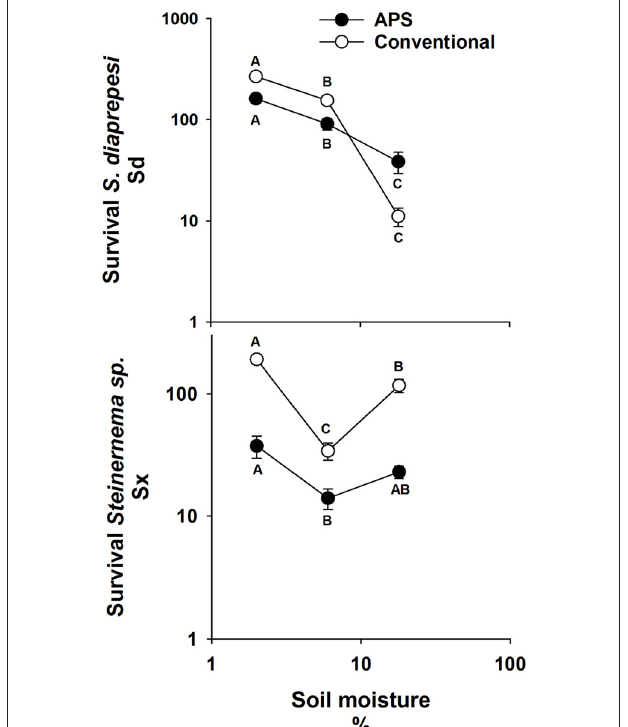
FIGURE 2 | Mean (and standard error) number of infective juvenile Steinernema sp. and S. diaprepesi recovered following 7 d of storage in field capacity (6%) or saturated (18%) sand that originated from experimental field plots managed with conventional or advanced citriculture methods. Data shown on log scaled axes. Points on the same curve with the same letters do not differ significantly ( P > 0.05) according to Tukey’s HSD-test. Sd = Steinernema diaprepesi , Sx = Steinernema